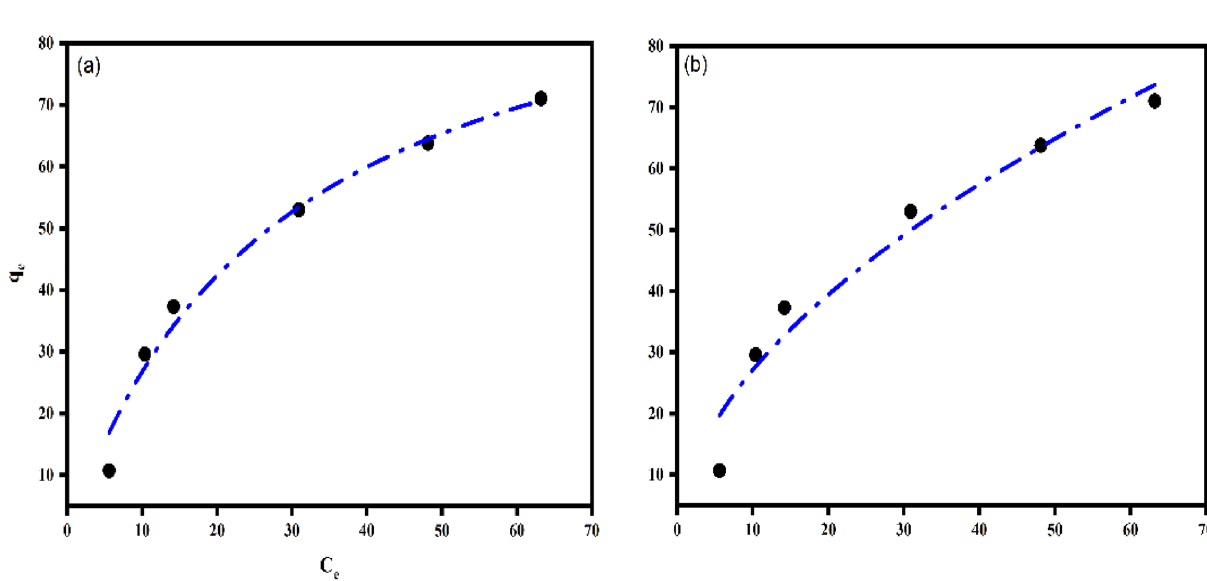
Figure 17. Non-linear isotherm plots of ( a ) Langmuir and ( b ) Freundlich isotherm models for the MB dye adsorption onto PVA/CMC/TUR